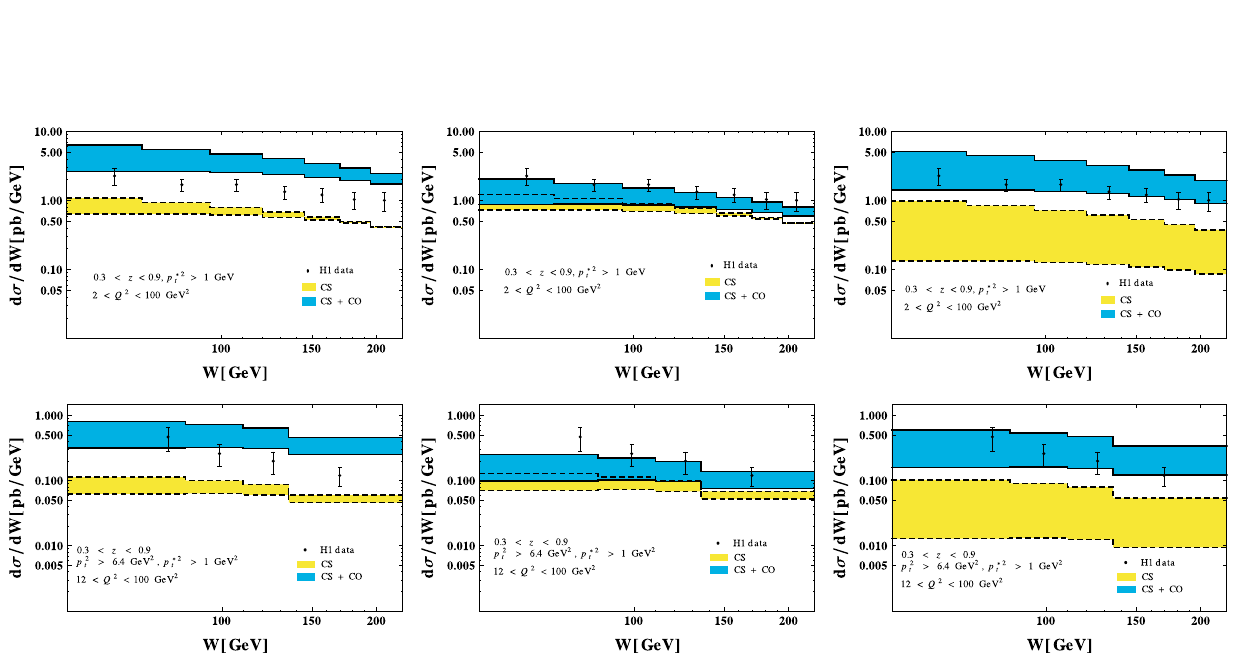
Fig. 9 The differential cross sections for the J /ψ production in DIS with respect to W . The experimental data are taken from Ref. [49]. The l.h.s., middle, and r.h.s. plots correspond to the LDMEs taken in Refs. [28,30,41], respectively